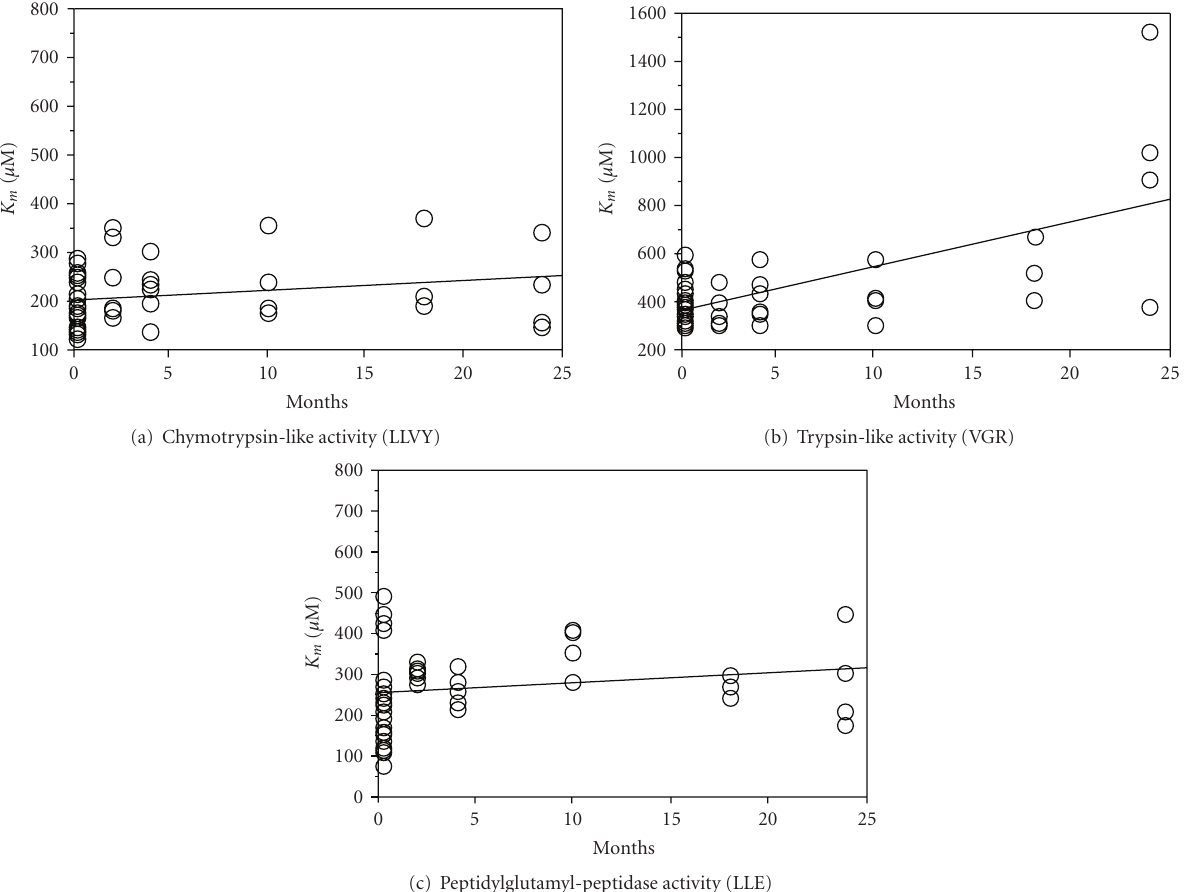
Figure 1: Michaelis-Menten constants ( K m ) of the proteasome in rat liver with age: regression plots of Michaelis-Menten constants ( K m ) of the proteasome in rat liver versus age. K m -constants were obtained from Lineweaver-Burk plots generated from proteolytic runs using four di ff erent substrate concentrations. For each concentration, triplicate samples were run. (a) Chymotrypsin-like activity: R 2 of the regression line is 0.049, P = . 138 . (b) Trypsin-like activity: R 2 = 0 . 417, P < . 001 . (c) Peptidylglutamyl peptidase activity: R 2 = 0 . 034, P = . 219 . A P -value of less than .05 was considered statistically